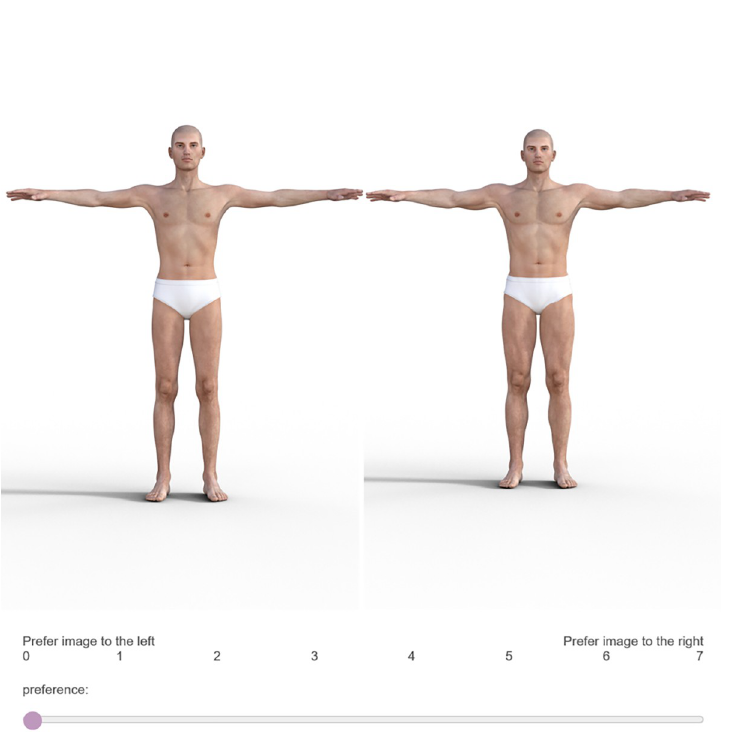
Fig 1. Example trial from the pre- and post- manipulation preference